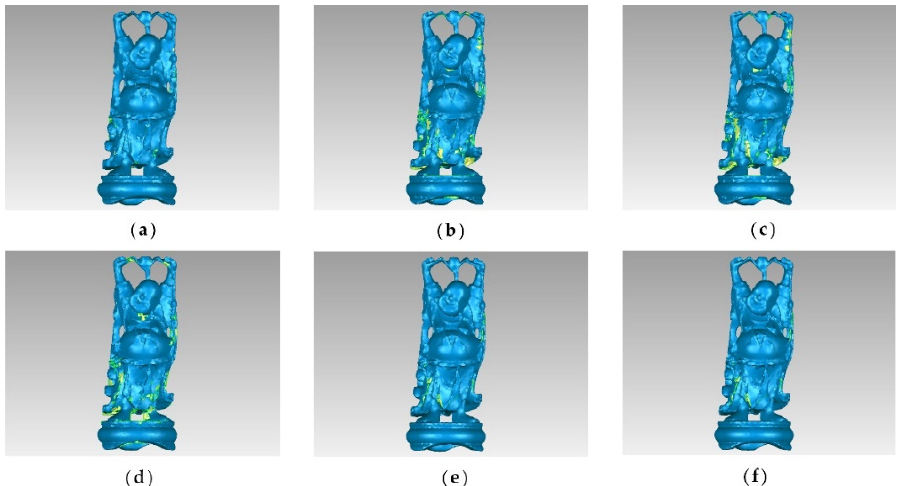
Sensors 2022 , 22 , x FOR PEER REVIEW 14 of 23